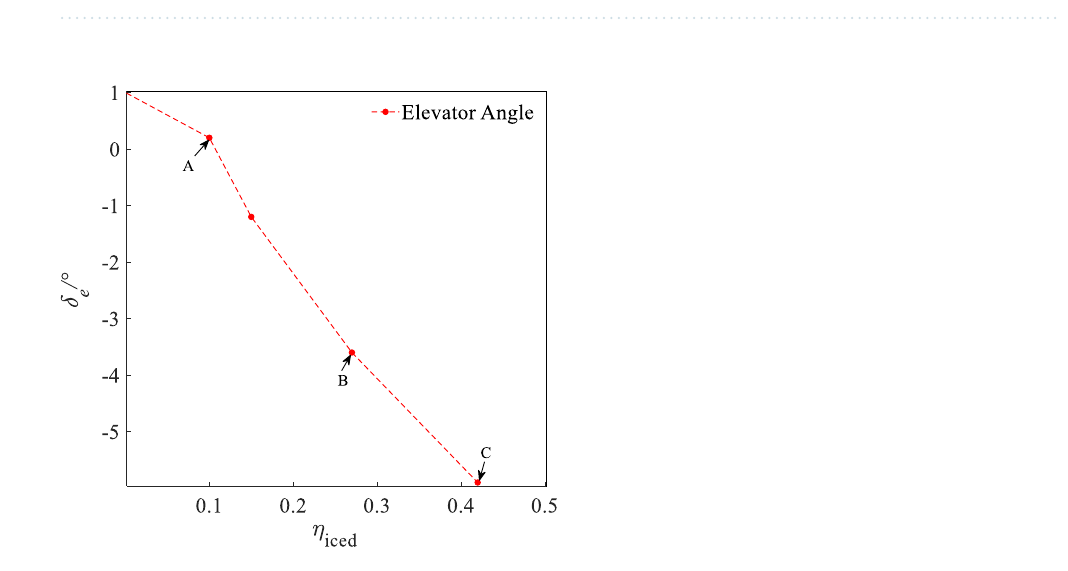
Figure 13. Balancing value of angle of attack.